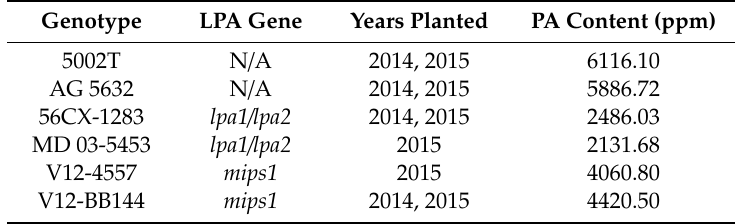
Table 1. The phytic acid (PA) content, genetic source of the low-PA (LPA) trait, and the years planted for each soybean genotype in this study. Genotype LPA Gene Years Planted PA Content